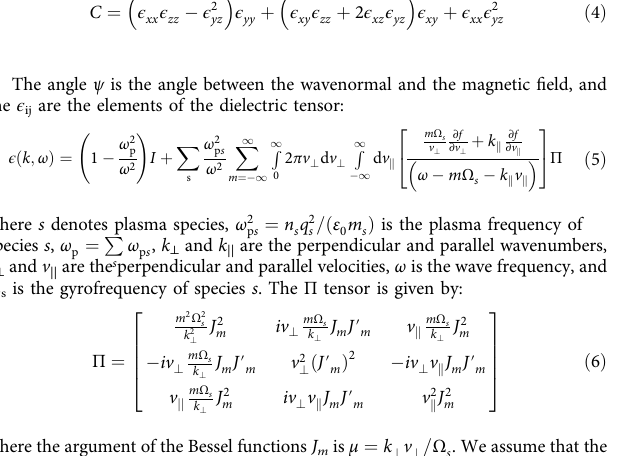
Construction of an observational dispersion relation . The underlying azimuthal structuring of the auroral arc is quantitatively characterised by use of an arc- tracking algorithm to determine the latitudinal position of the arc in the fi eld of view of the ASI as the substorm develops at each location between − 97.0 and − 90.0 geomagnetic longitude prior to the arc breaking-up into multiple auroral arcs, at 09:26:00 UT. By tracking the arc for a signi fi cant amount of time, we can generate an along-arc keogram (Fig. 1b) which contains both temporal and spatial information of the auroral arc. In producing the along-arc keogram, it is assumed that the 557.7 nm auroral emission is located at 110km altitude and has very little vertical extent. This assumption does not affect the projection of the beads at zenith